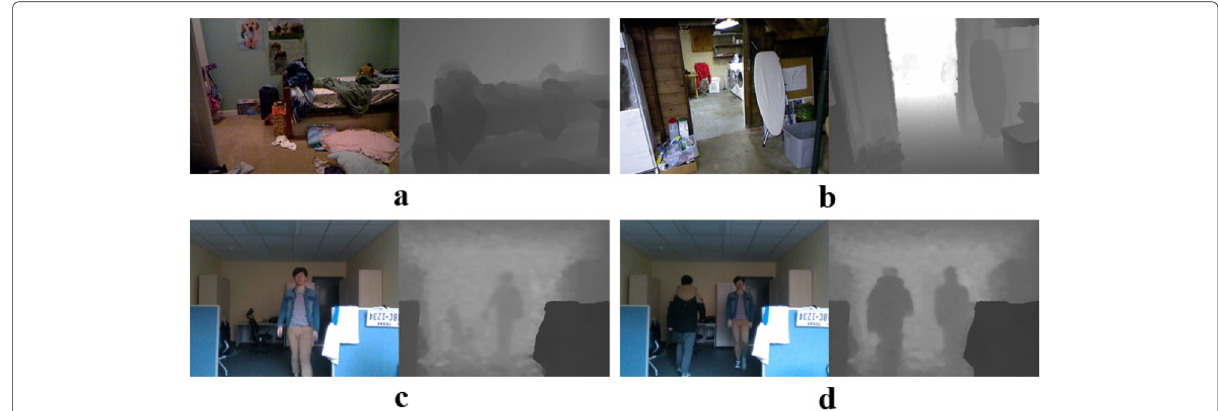
Fig. 10 Color and depth videos for simulation. a Bedroom, b basement, c a man, and d two